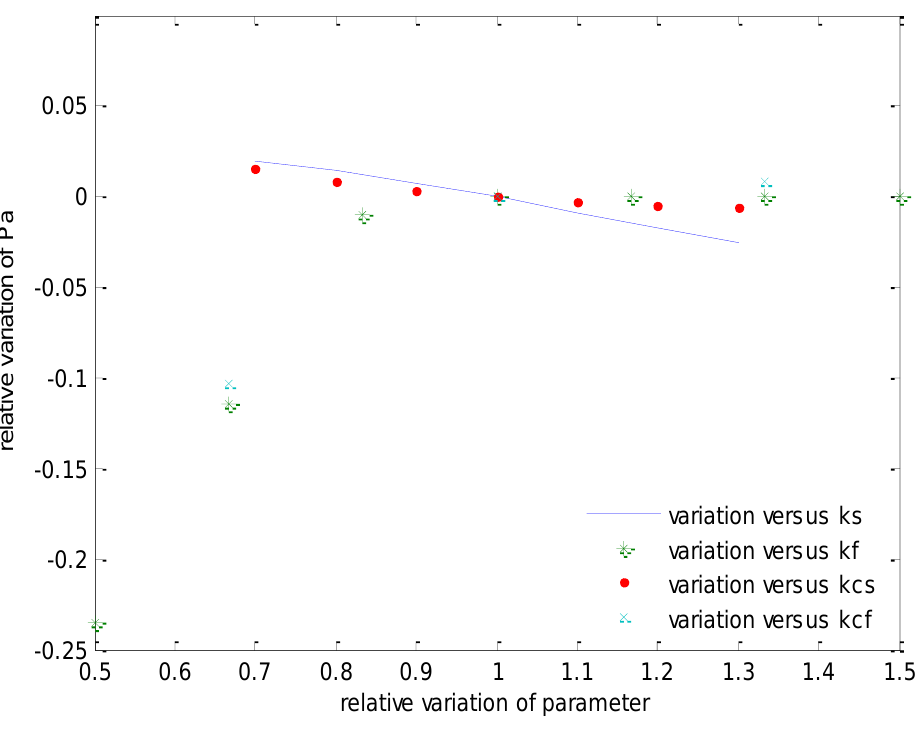
Fig. 5. The relative variation of P a with respect to parameter variations TSCSTFCF, p U =0.9, p L =0.6, α=0.05,